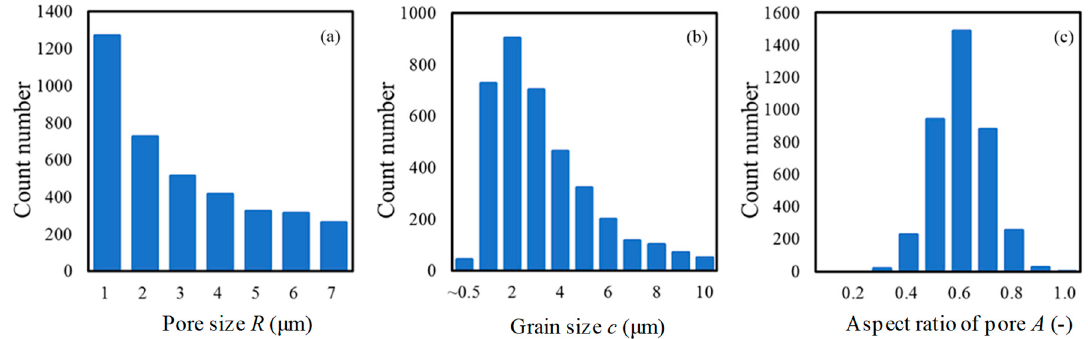
Figure A1. Histogram of the microstructure data of the elements obtained for an arbitrary specimen of the four-point bending test (length 40 mm) as shown in Figure 3. The distribution of the microstructure is defined as given in Table 2, while µ R = 0.8 and µ R + 3 σ R = 7.87 for the pore size: ( a ) pore size R ; ( b ) aspect ratio A ; and ( c ) grain size c (initial crack